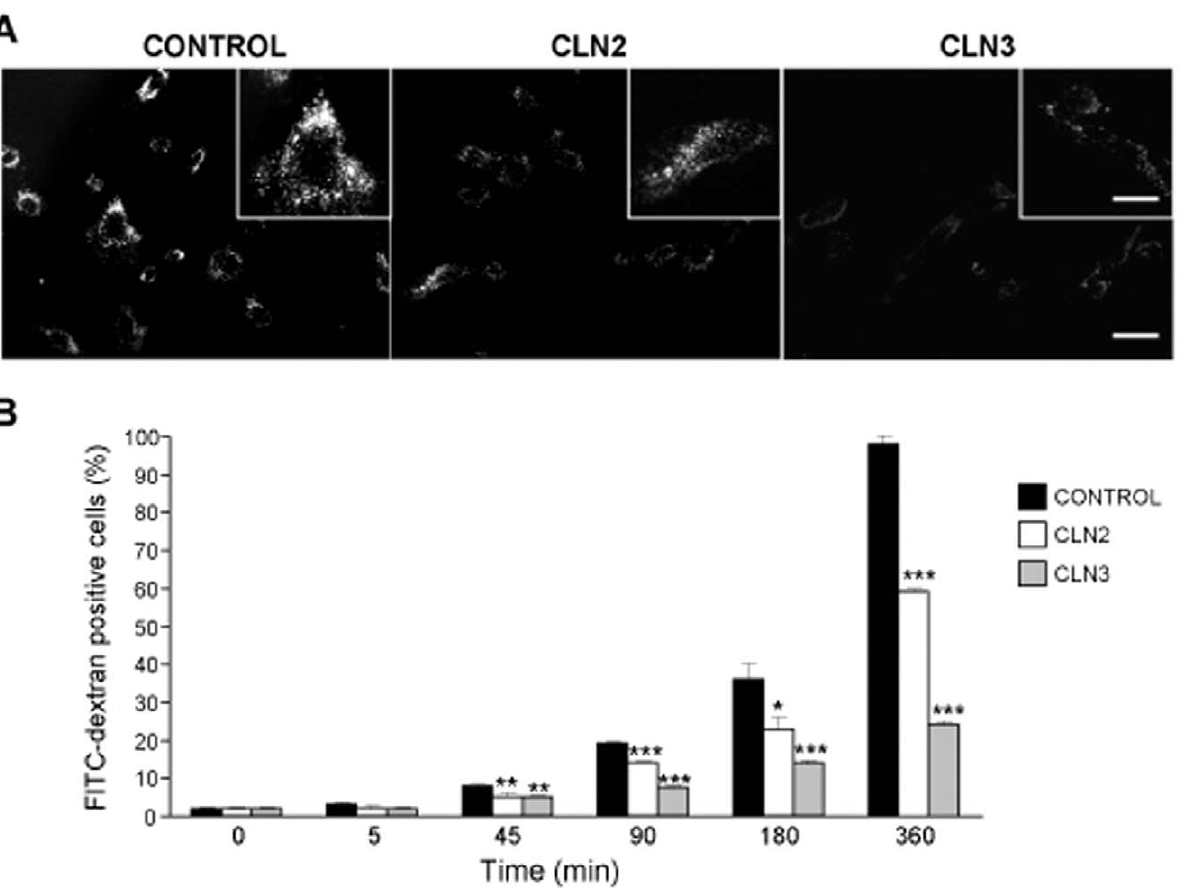
Figure 3. Macropinocytosis is reduced in CLN2 and especially in CLN3 fibroblasts. (A) Representative fluorescence microscopic images of control, CLN2 and CLN3 fibroblasts incubated at 37 u C for 2 h with 0.5 mg/ml FITC-dextran, followed by a 30 min chase. Bar: 50 m m. Insets show cells at higher magnification. Bar: 150 m m. (B) To quantify endocytic internalization, control, CLN2 and CLN3 fibroblasts were incubated at 37 u C for the indicated periods of time with 0.5 mg/ml FITC-dextran, washed and analyzed by flow citometry as described in Materials and Methods. Results indicate the percentage of fluorescently labelled cells, and are the mean and S.D. from three separate experiments with triplicated samples. Representative dot blots are shown in Figure S3A. Stars indicate statistically significant differences from the corresponding control values at each time (*p , 0.05, **p , 0.01 and ***p , 0.005).